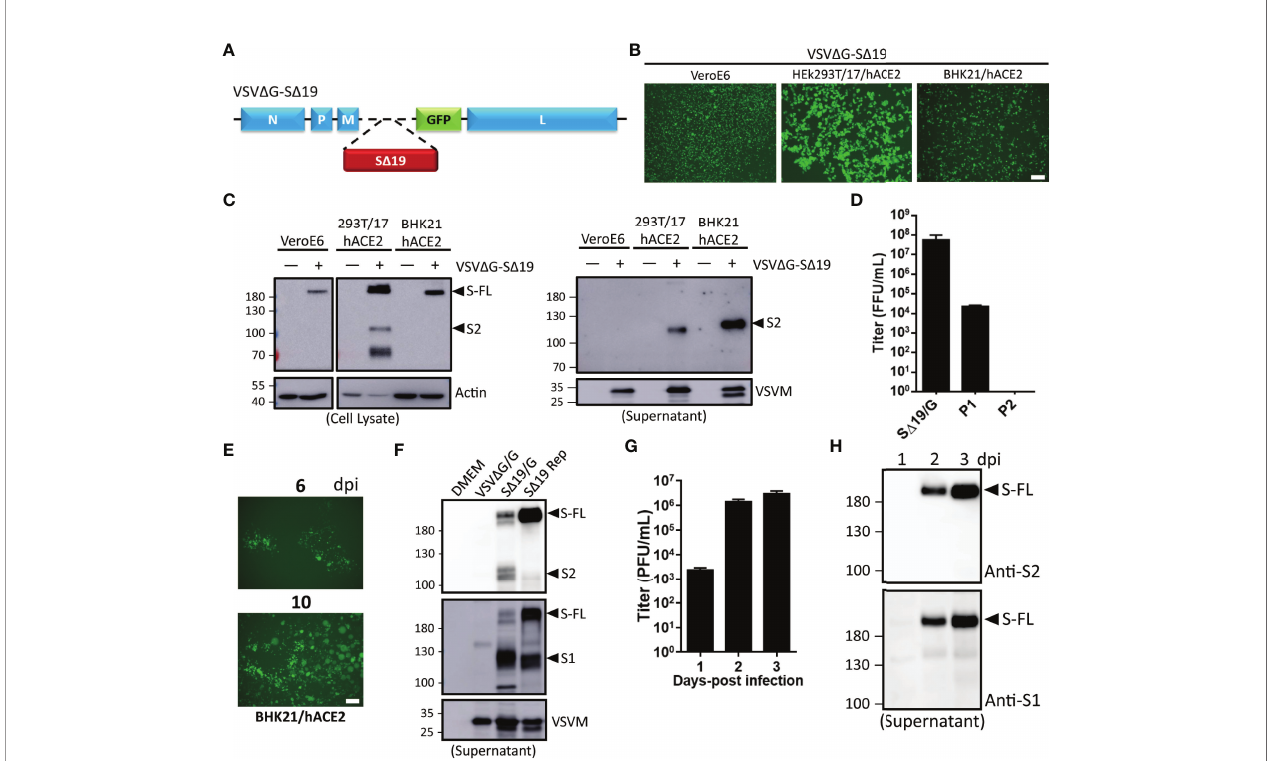
FIGURE 1 | Generation of recombinant vesicular stomatitis virus (VSV) expressing the C-terminal 19 amino acid deletion SARS-CoV-2 spike mutant (VSV D G-S D 19) with replication capability. (A) Schematic representation of the genomic organization of the G protein-de fi cient VSV vector (VSV D G) inserted with the C-terminal 19 amino acid truncated SARS-CoV-2 spike protein (S D 19). N, nucleoprotein; P, phosphoprotein; M, matrix; GFP, green fl uorescent protein; L, large polymerase. (B, C) Vero E6, HEK293T-hACE2, and BHK21-hACE2 cells were infected with the VSV D G-S D 19 virus (early passage, moi=0.5). Virus-driven GFP expression was monitored by fl uorescence microscopy at 24 hrs post-infection (B) . The S D 19 protein expression in cells (left panel) and supernatant (right panel) was examined by immunoblotting (C) . (D) The VSV D G-S D 19 virus was propagated in HEK293T-hACE2 cells, and the virus titer was determined in BHK21-hACE2 cells. (E) After a few passages in HEK293T-hACE2 cells, the viruses were inoculated in BHK21-hACE2 cells with limiting dilution. The replication-competent VSV D G-S D 19 viruses (S D 19 Rep) emerging from BHK21-hACE2 cells were observed with GFP monitoring. (F) The S protein expression on recombinant virus particles of VSV D G/G, the early passage of VSV D G-S D 19 enveloped with the VSV glycoprotein (S D 19/G; replication incompetent) and S D 19 Rep virus was examined by immunoblotting. (G, H) Vero E6 cells were infected with the S D 19 Rep virus (moi=1, n=3). Virus titer (G) and S protein expression on virus particles (H) in culture supernatant were examined. moi, multiplicity of infection; dpi, days post-infection. Scale bar: 100